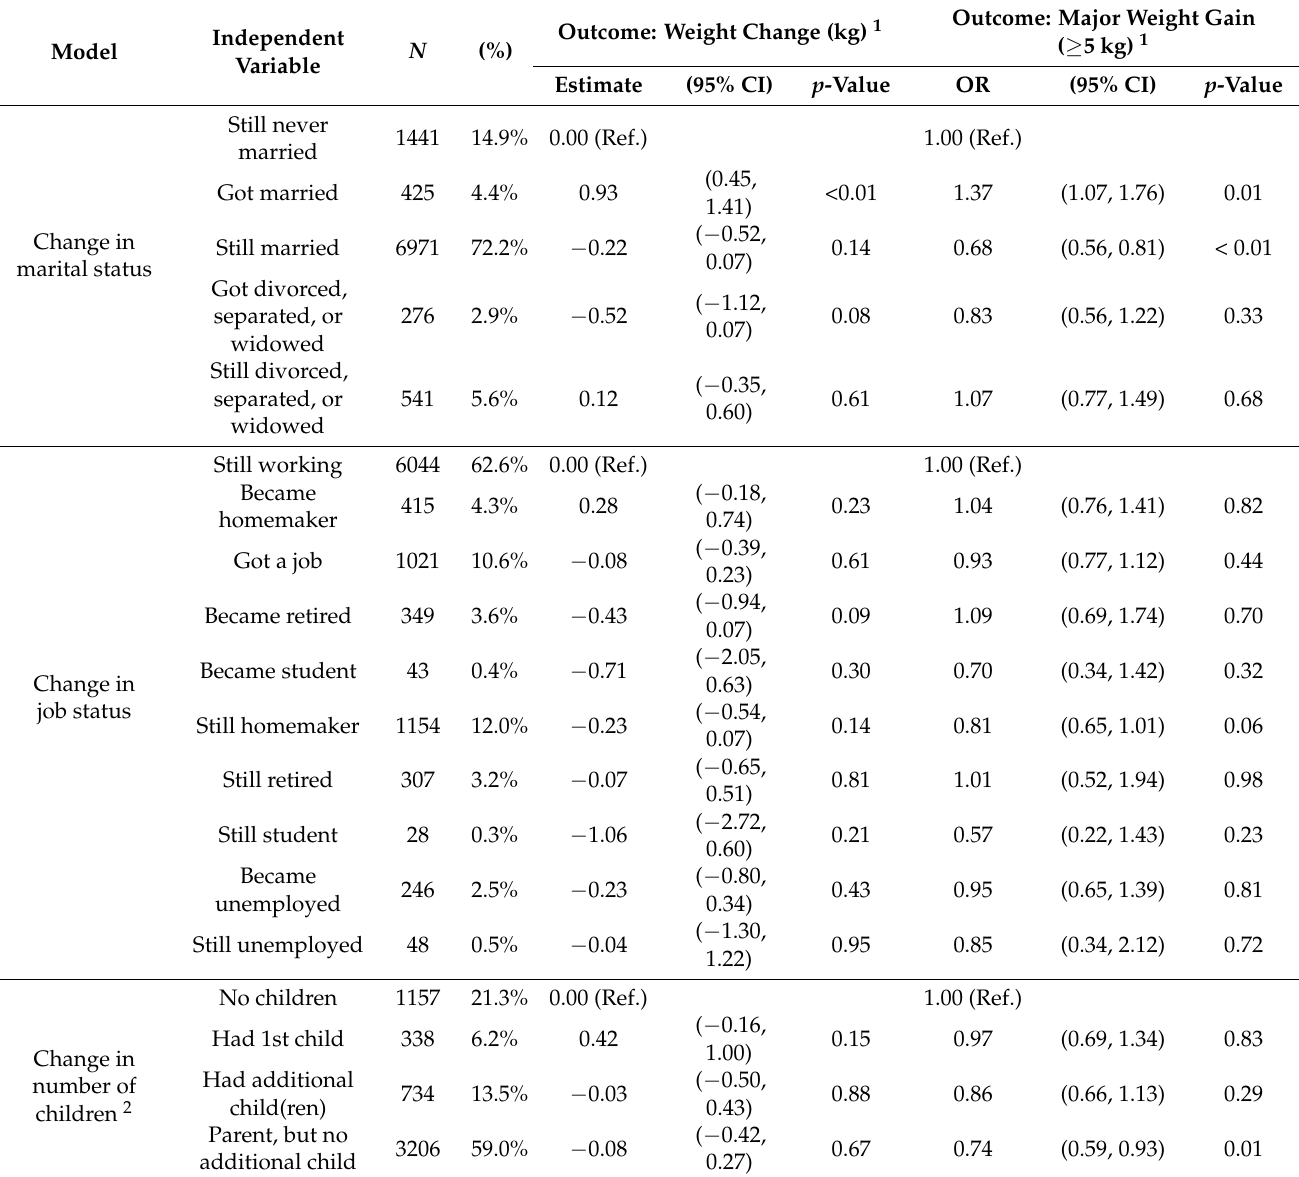
Table 3. Longitudinal associations between lifestyle transitions and weight changes in Singapore Multi-Ethnic Cohort participants aged 21 years and